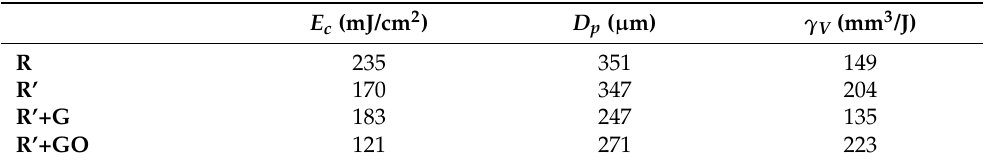
Table 5. E c and D p obtained from Jacobs’ working curves of acrylic-based resin and its nanocomposites.